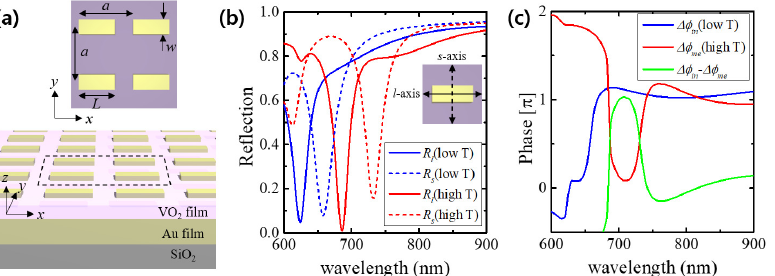
Figure 2. Reflectarray metasurface with VO 2 thin film ( a ) Schematics. ( b ) Temperature dependent reflection spectra with different polarization directions of the normal incident light. ( c ) Temperature dependent phase-difference spectra between l -axis and s -axis polarizations, and phase spectrum subtracting the two